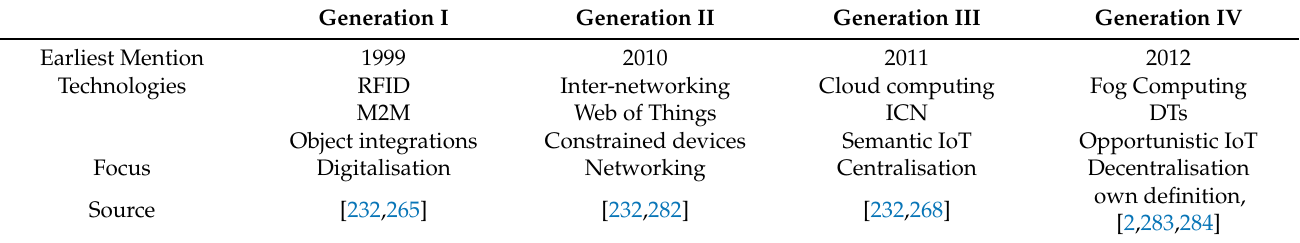
Table 3. Waves of IoT